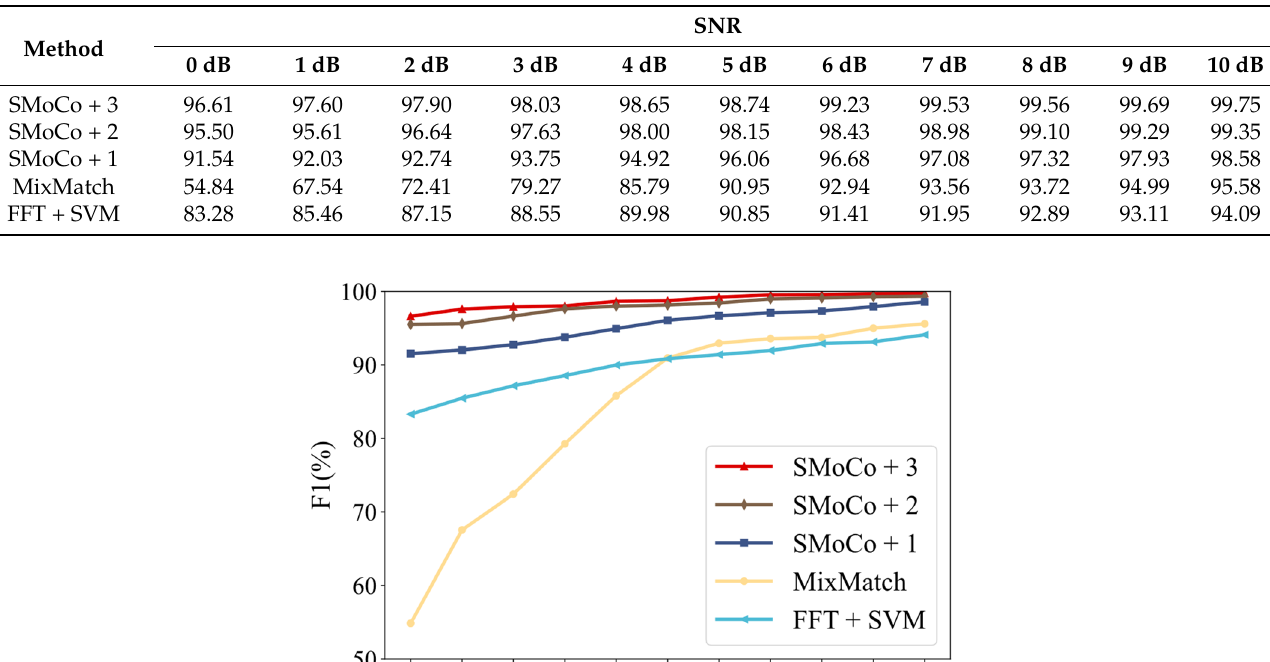
Table 10. Experimental results of the sensitivity to the SNR on the aero-engine bearing dataset.